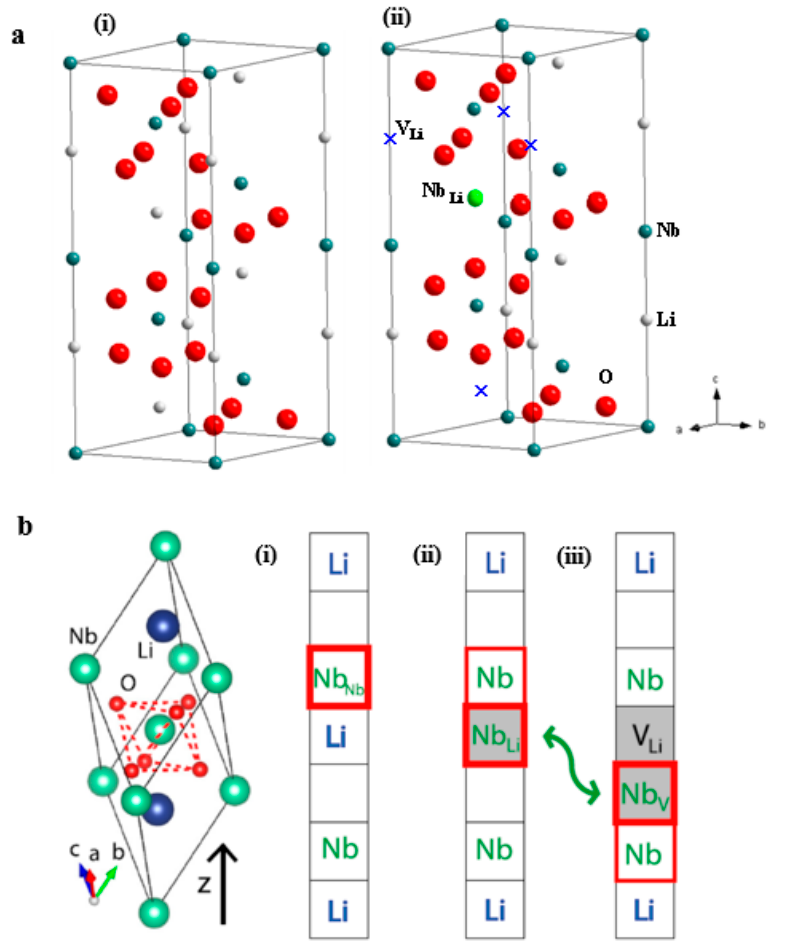
Figure 2. ( a ) Crystal structures of stoichiometric LiNbO 3 (i) and congruent LN with anti-site Nb Li4+ and V Li − defects (ii) [22]; ( b ) Free and defect-bound (bi)polarons in LiNbO 3